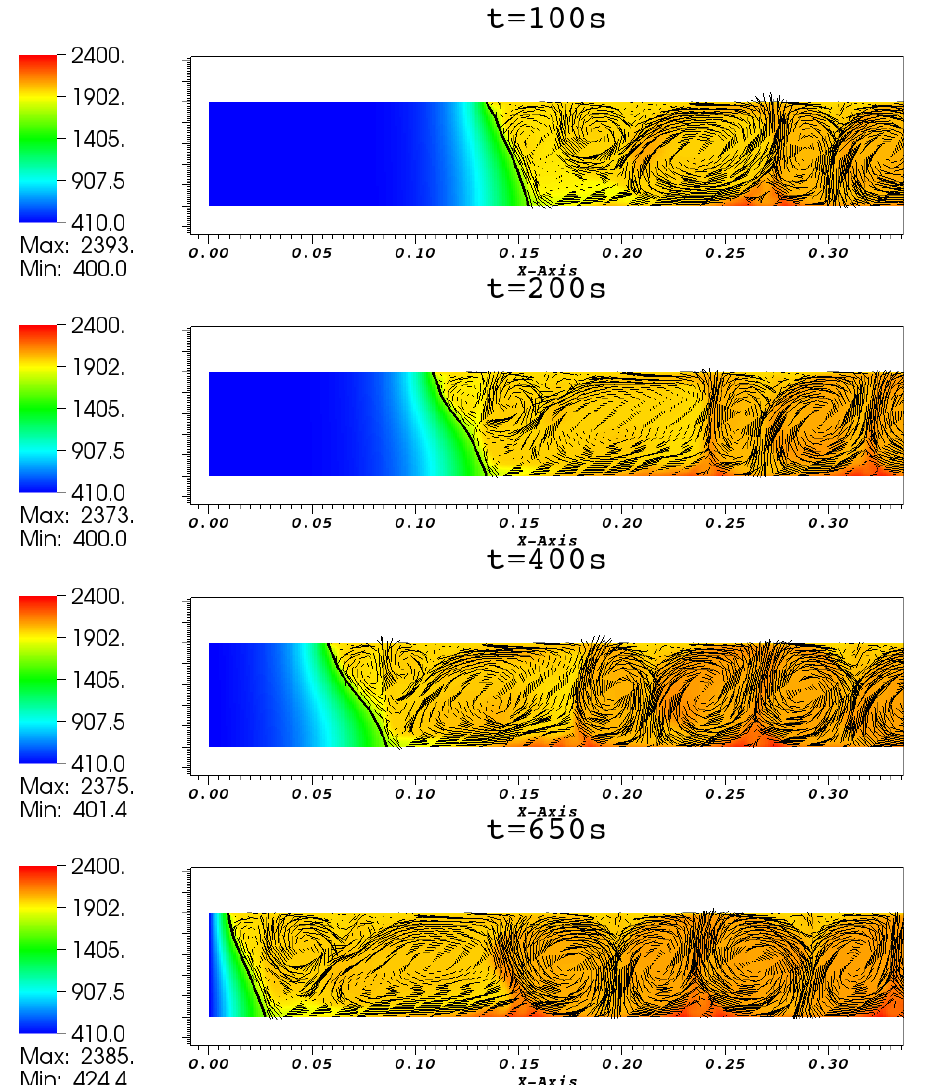
Figure 12. Two-dimensional thin metallic layer test case—Temperature field obtained for the thin metal layer and the vessel for different intermediate times t ∈ { 100,200, 400,650 } s—Temperature in colors, velocity as thin black lines, interface as a thick black